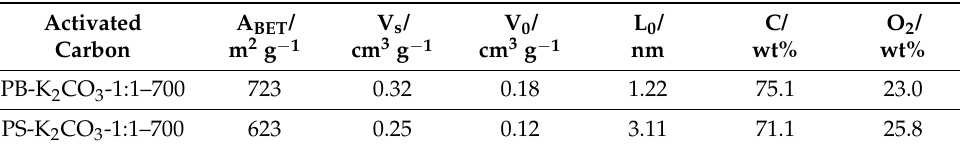
Table 2. Textural and chemical characteristics of the PB-K 2 CO 3 -1:1–700 and PS-K 2 CO 3 -1:1–700. In Table 2, the A BET (N 2 ) is the apparent surface area, Vs and V 0 are the total and microporous volume, respectively, and L 0 is the mean pore